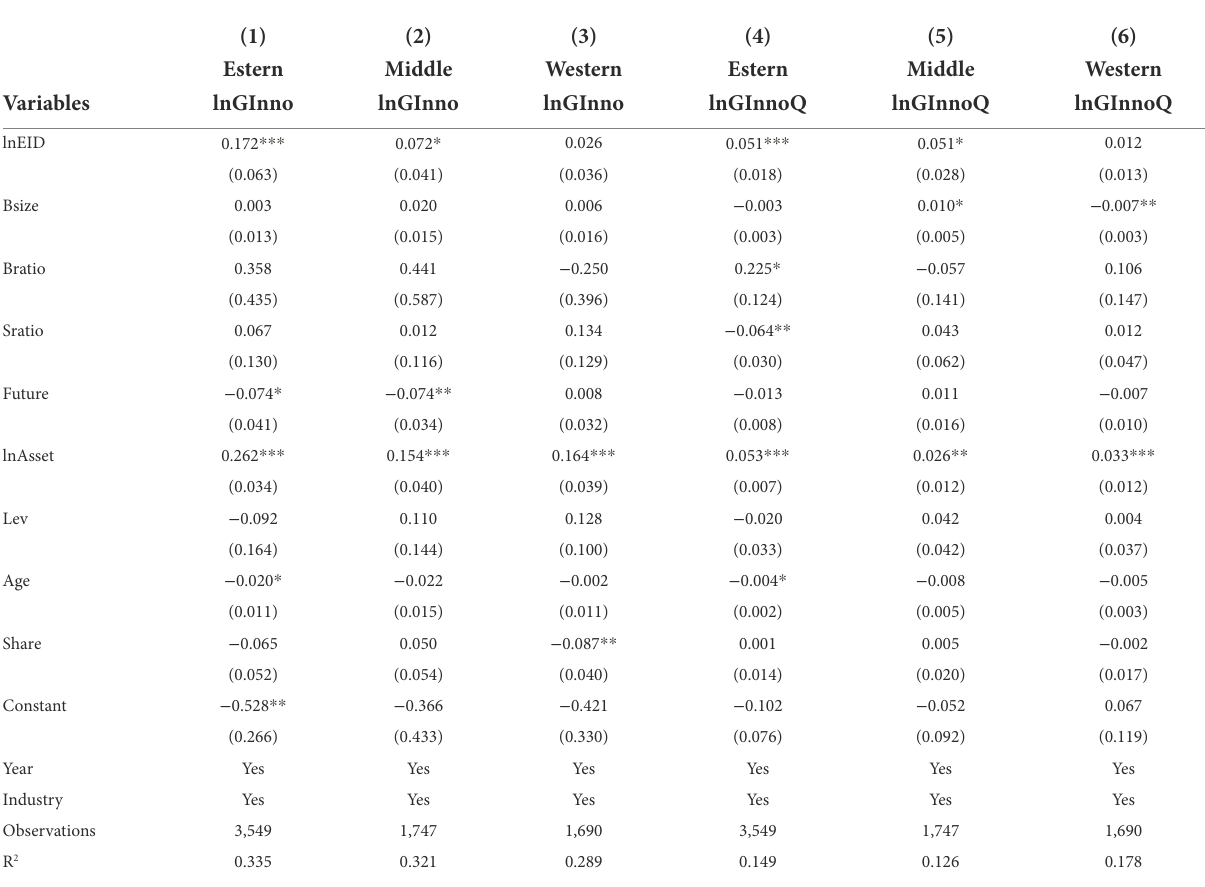
TABLE 7 Heterogeneity in the geographical location of